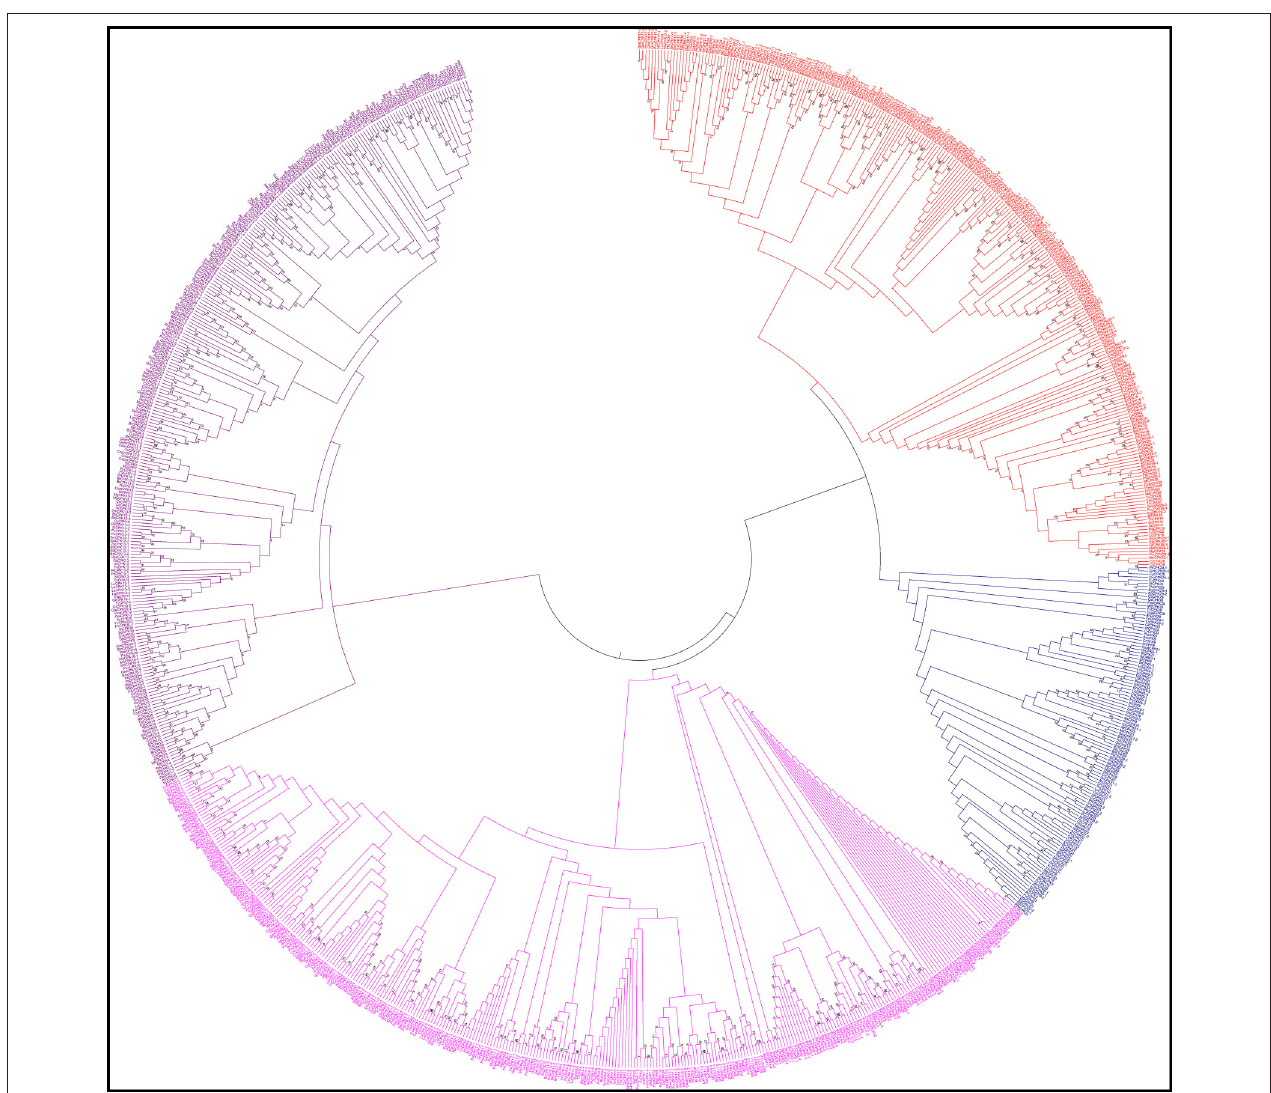
FIGURE 5 | Phylogenetic tree of calcium-dependent protein kinases (CPKs). The CPKs of monocots, dicots, green algae, bryophytes, pteridophytes, and gymnosperms were searched from different genome databases using CPK genes of Arabidopsis thaliana as queries. Identified sequences were only accepted if the corresponding proteins had serine/threonine protein kinase domain and four calcium binding EF-hand domains. A phylogenetic tree was constructed using Molecular Evolutionary Genetics Analysis 6 (MEGA 6) by neighbor joining method with 1000 bootstrap replicates. The constructed phylogenetic tree showed that, CPKs are clustered into four different groups: A (red), B (blue), C (fuschia), and D